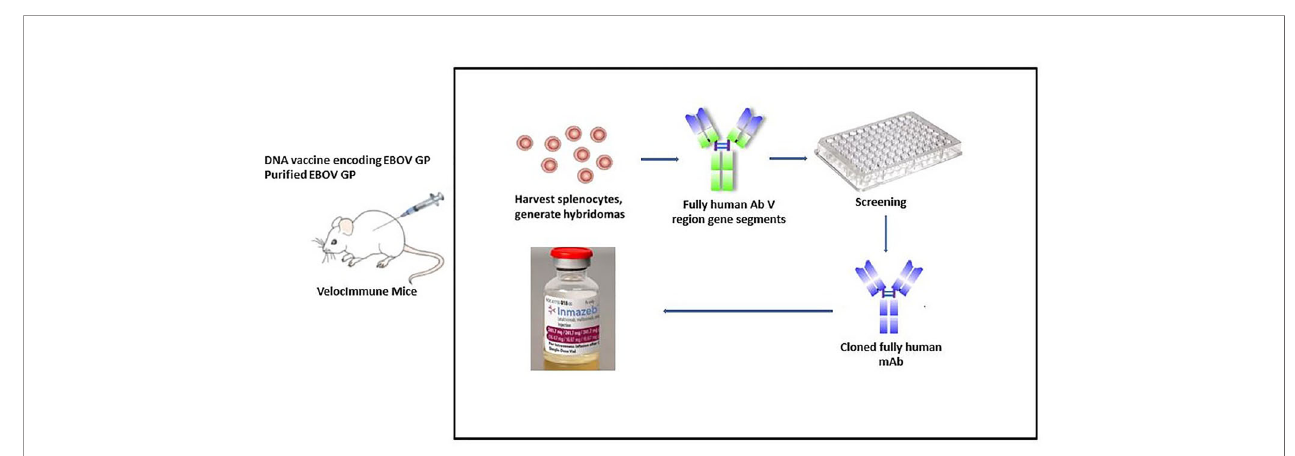
FIGURE 4 | REGN-EB3 development technique. To generate an immune response, transgenic mice (VelocImmune) are immunized with a DNA vaccine encoding EBOV GP and/or recombinant EBOV GP. Splenocytes are harvested and fused with myeloma cells to create hybridoma cells that produce antibodies continuously. Selected leads are utilized to generate chimeric or humanized antibodies after they have been